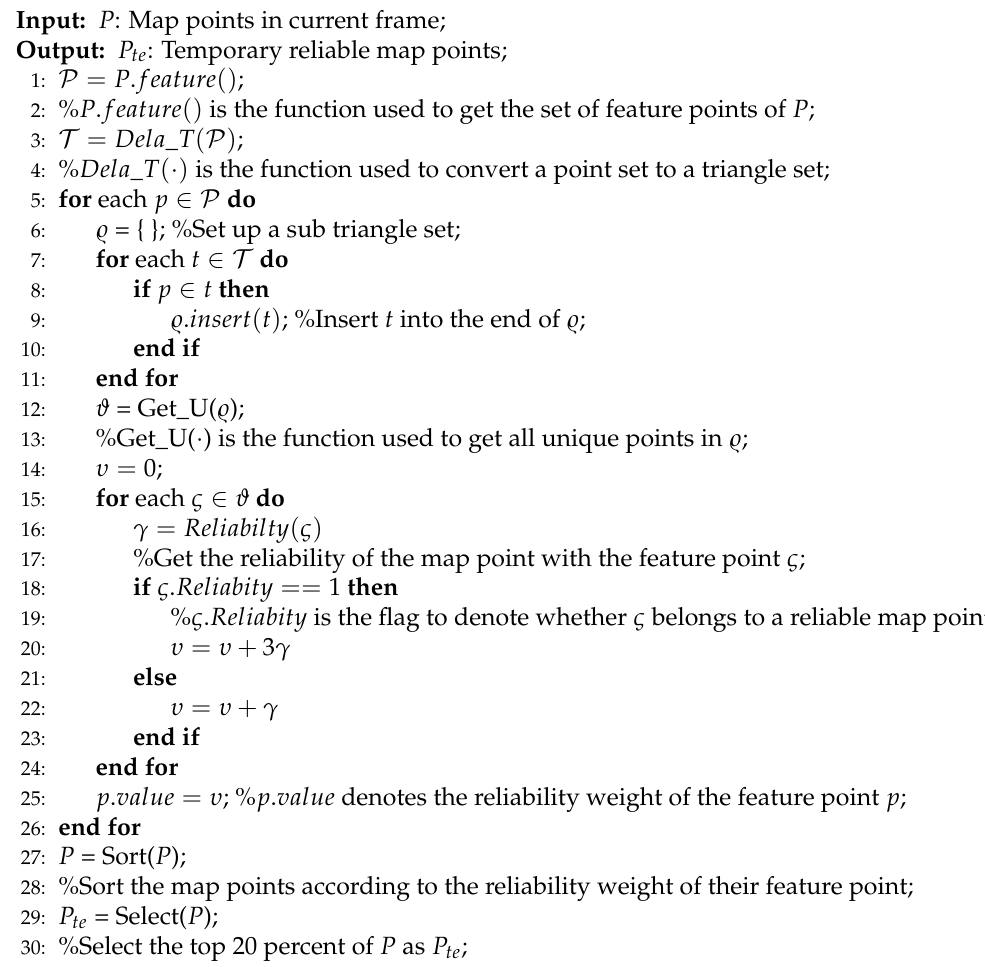
Algorithm 2 The proposed MPS